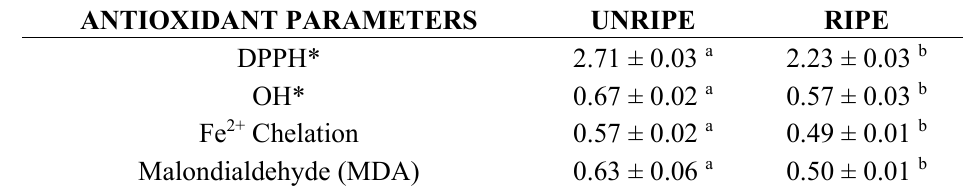
Values represent means ± standard deviation of triplicate ( n = 3). Values with the different alphabet along the same row (for the same parameter) are significantly different ( p >